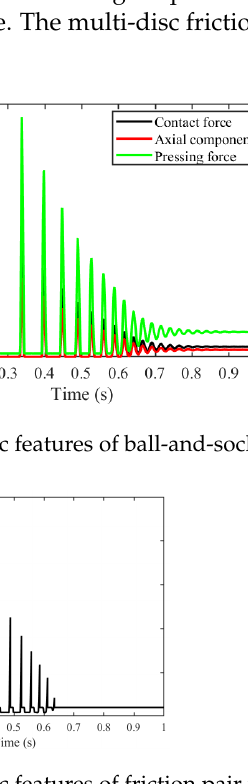
Figure 11. Dynamic features of friction pair under reverse load.